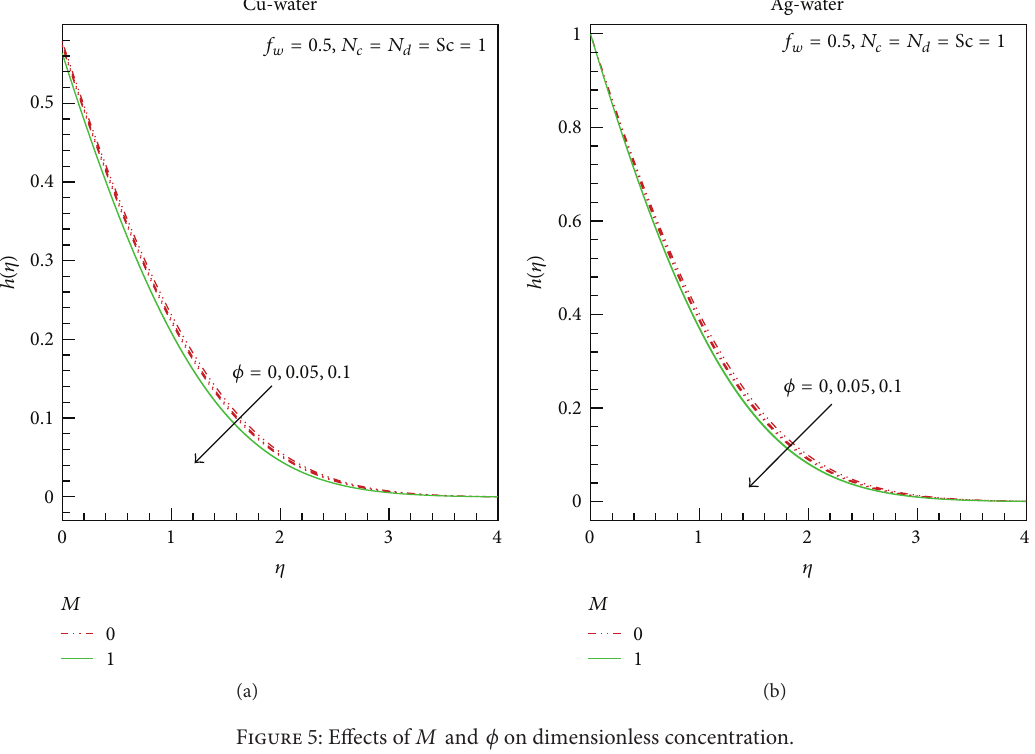
Figure 5: Effects of 𝑀 and 𝜙 on dimensionless concentration.